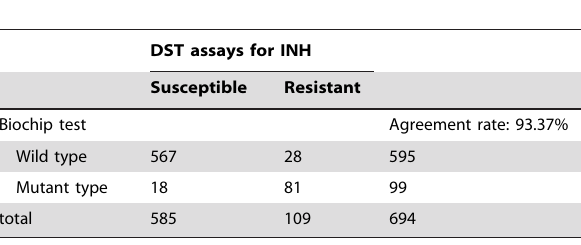
Table 1. Comparison of DST and biochip for rifampicin resistance pattern * .